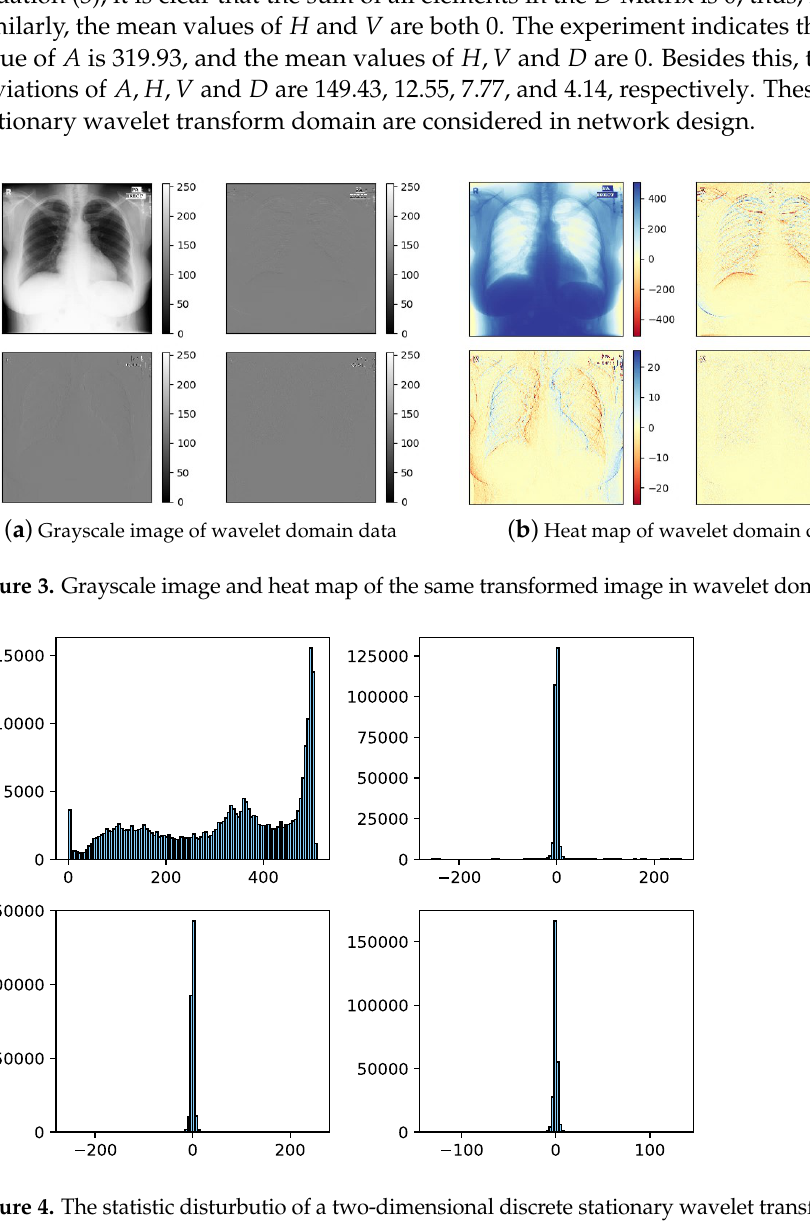
Figure 4. The statistic disturbutio of a two-dimensional discrete stationary wavelet transformed